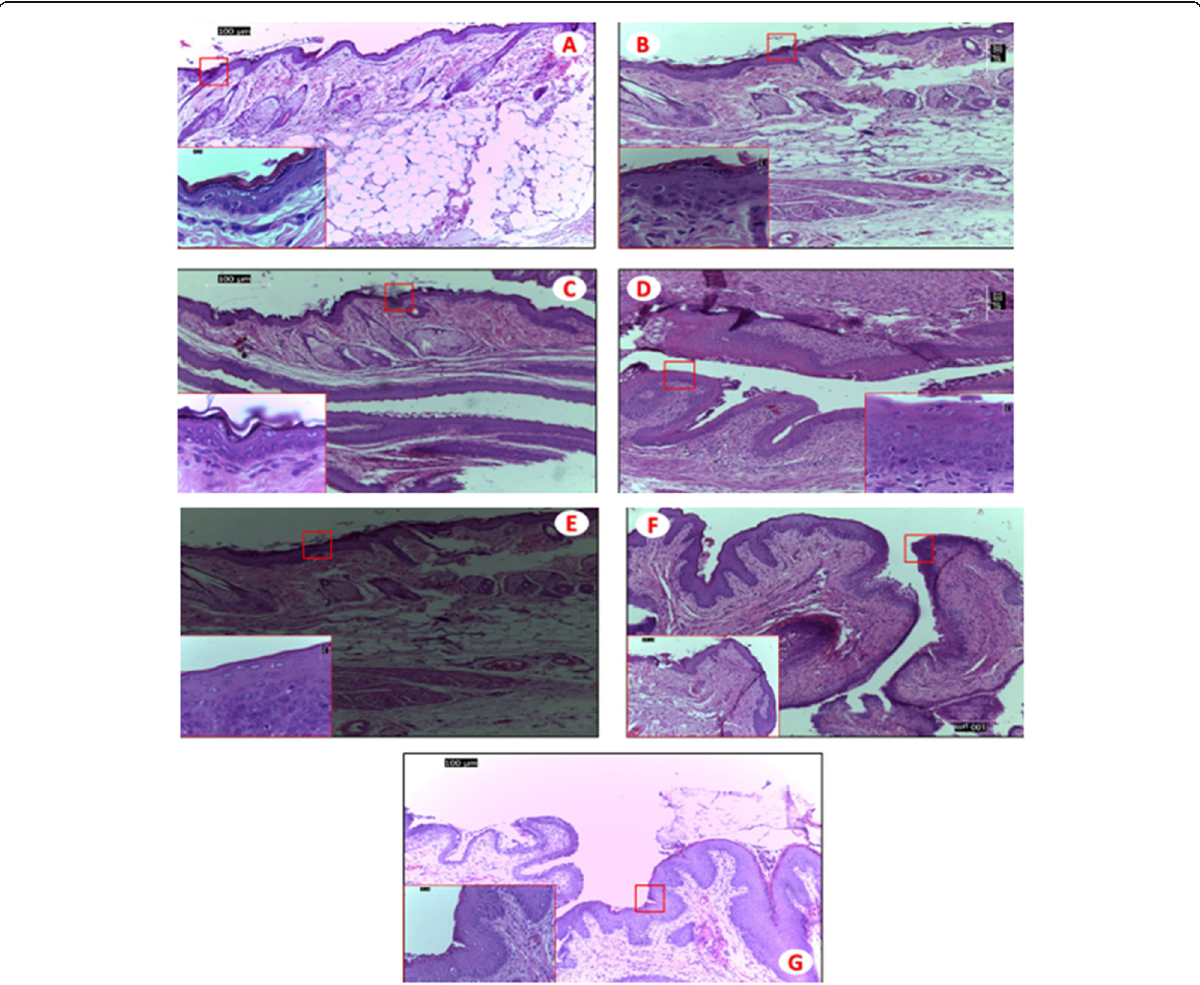
Fig. 5 Hematoxylin and eosin-stained sections of mice vagina. Light micrographs (× 100 and × 1000 (red square) of the vaginal mucosa of mice after 14 days of daily treatment with 0.04 mls of 1:20 dilution. a BG A. b BG B. c BG C. d BG D. e Bigel without maraviroc and tenofovir. f N9 gel.